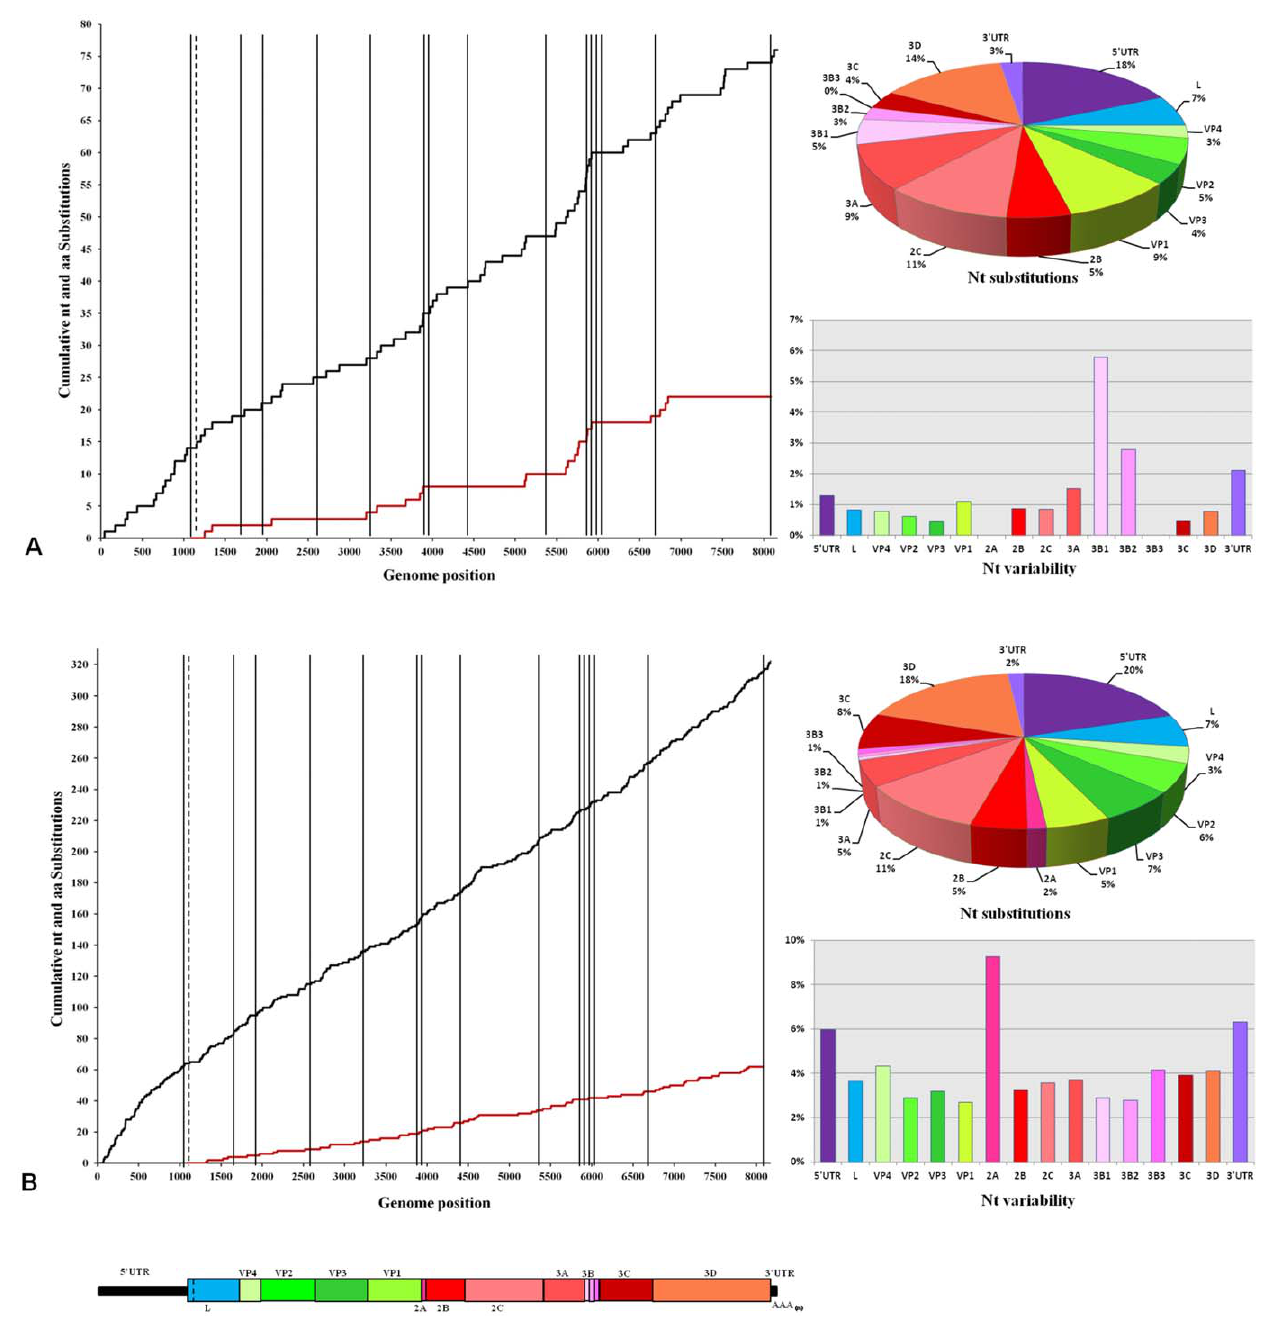
Figure 2. Nucleotide and amino acid substitutions occurring along the genome of the FMDV sequences. A ) Data for sequences from Bulgaria (8 genomes): graphs represent the distribution of total nucleotide (nt) (black line) and non-synonymous (red) substitutions across the different genomic regions of FMDV (shown below). The pie chart and the bar chart show percentage of nt substitutions for each region, and nt variability within the region, respectively. B ) Similar analysis to figure 2A) undertaken for the 11 FMDVs genomes from Turkey and Israel.